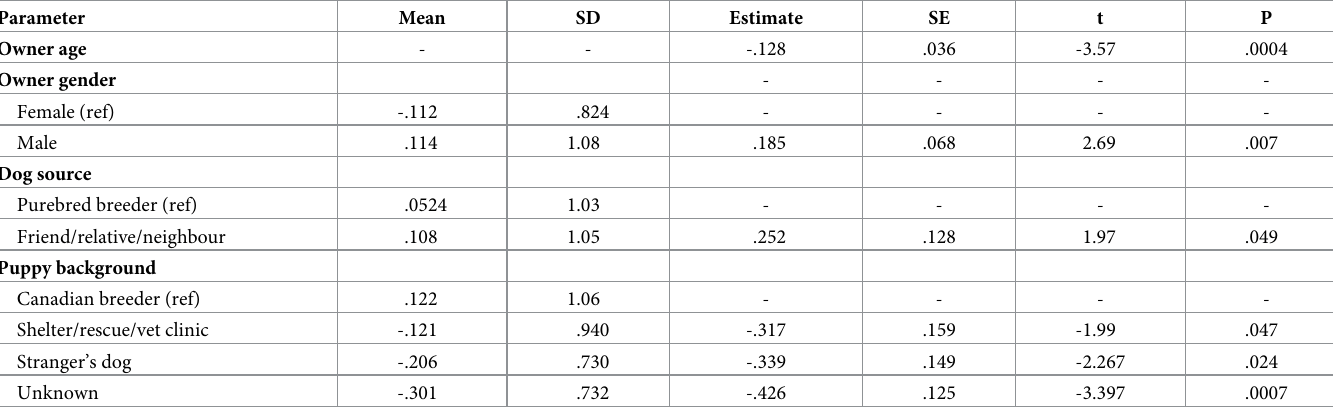
Table 4. Statistical significance of owner and dog parameters on CBARQ Factor 1 “Difficult behaviour”.